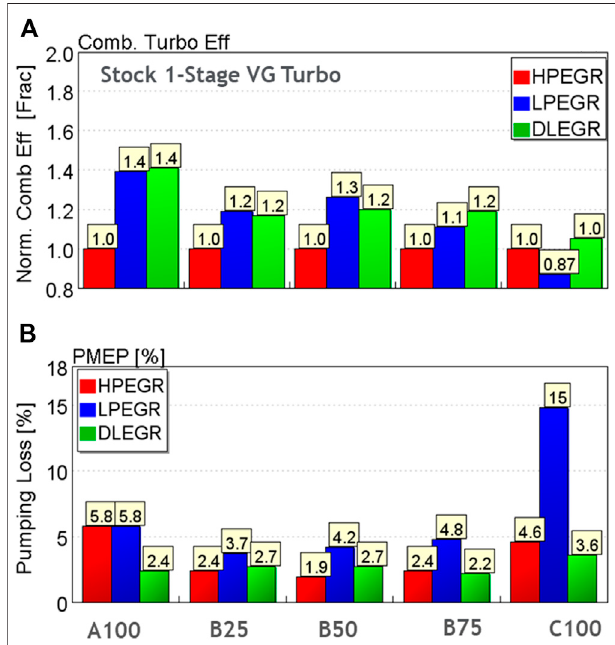
FIGURE 6 | (A) Normalized combined turbo ef fi ciencies and (B) PMEP % comparisons for Stock 1-Stage VG Turbocharger using various EGR con fi